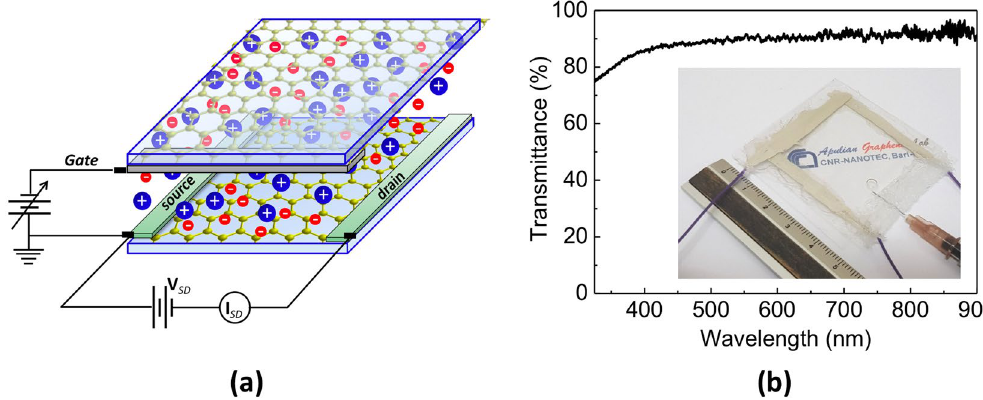
Figure 1. ( a ) Sketch of graphene electrolytic capacitor. By applying gate voltage, carriers of opposite signs are accumulated on graphene electrodes whose Fermi levels are shifted in valence and conduction band. ( b ) Optical transmittance of the graphene electrolytic capacitor. Inset: picture of the fabricated